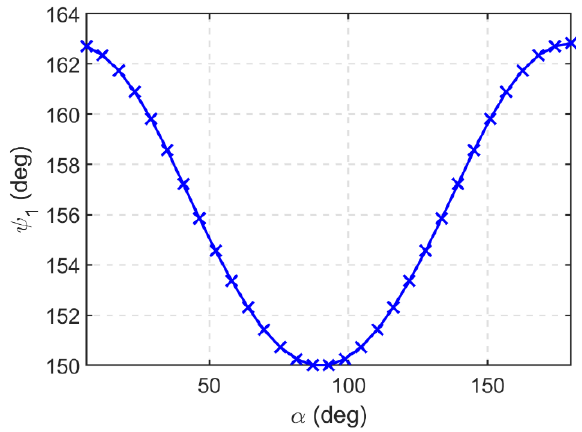
Figure 5. Geometrical variables ψ 1 and α used to reproduce results shown in Figure 6.